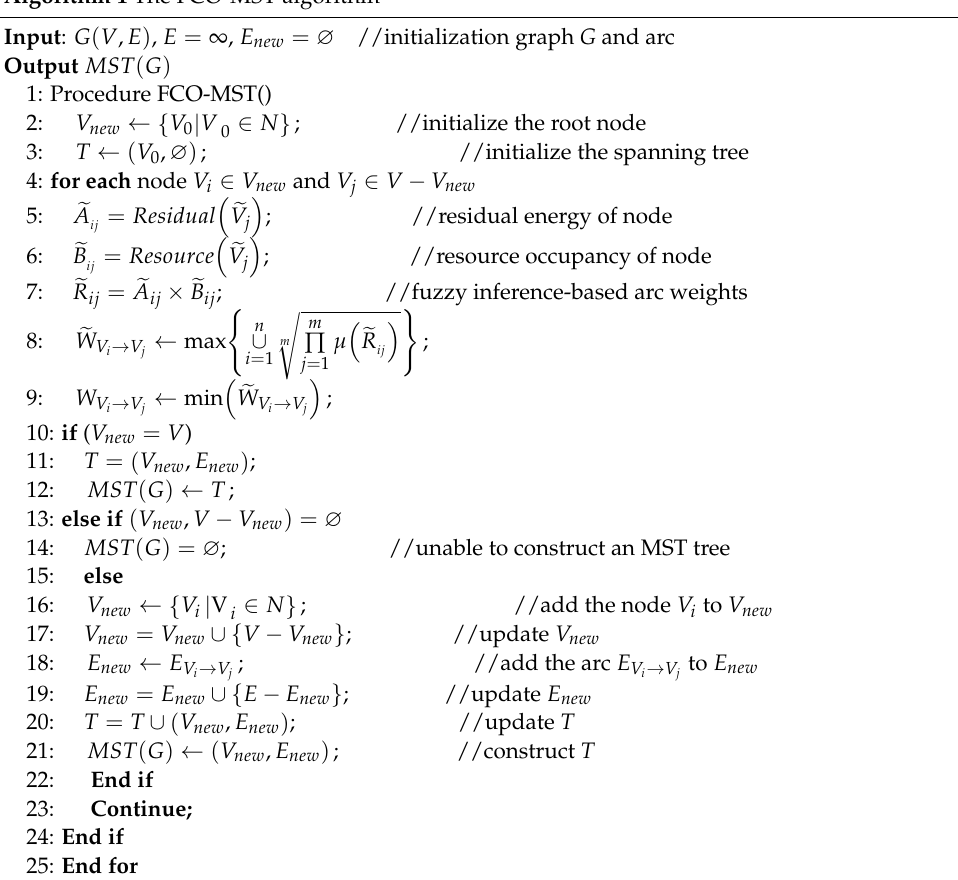
Algorithm 1 The FCO-MST